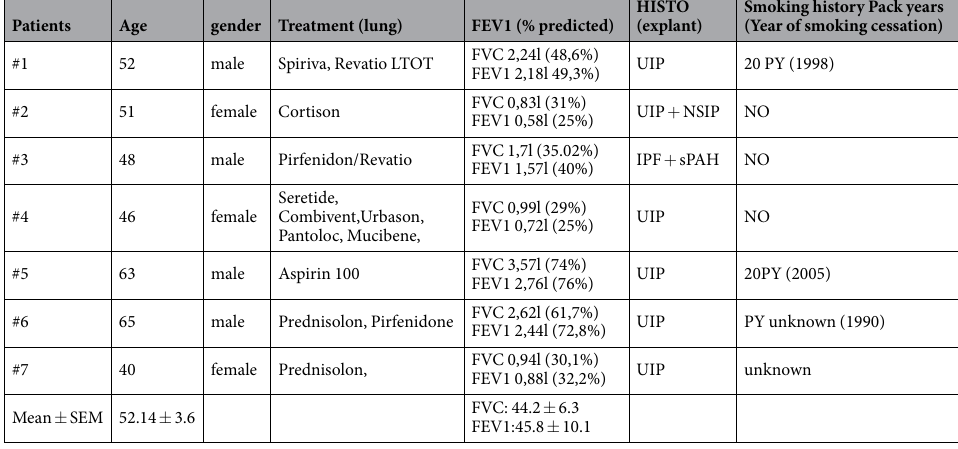
Table 1. Clinical characteristics of IPF